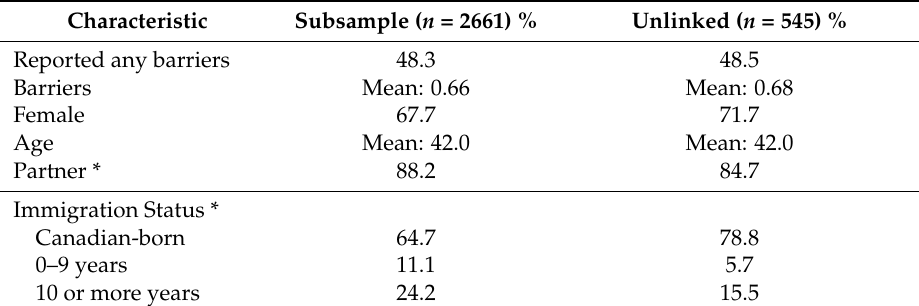
Table 3. Comparison of linked subsample with unlinked